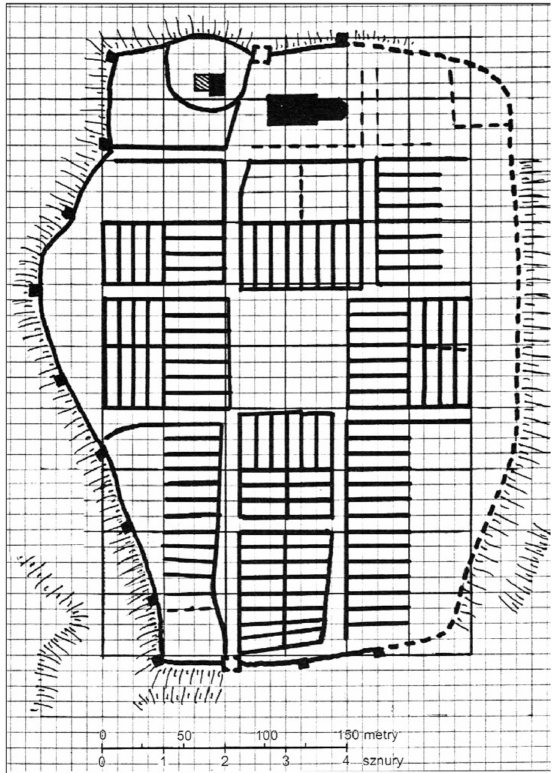
Figure 1. Hand-drawn sketch of the most important elements of the city layout on the background of the squares grid, example of Wieliczka